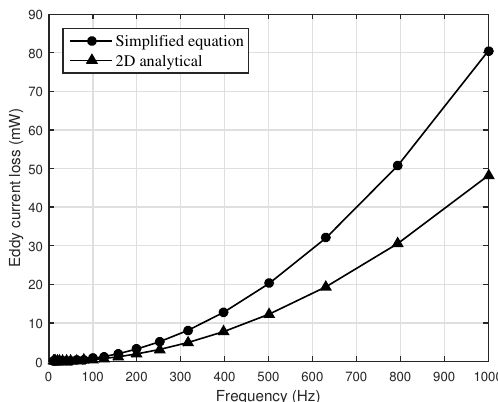
Figure 4. Comparison of loss vs. frequency between analytical